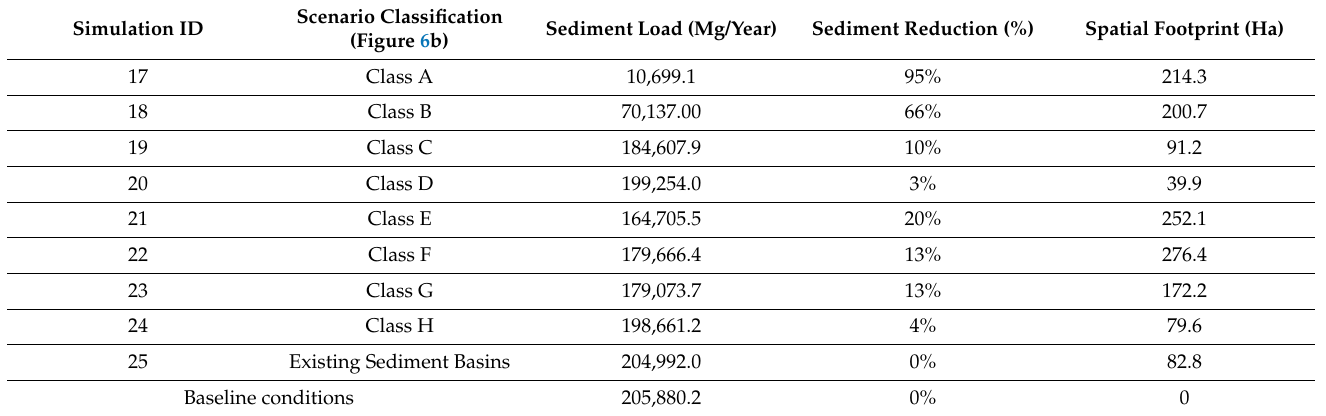
Table 5. Sediment basin scenarios